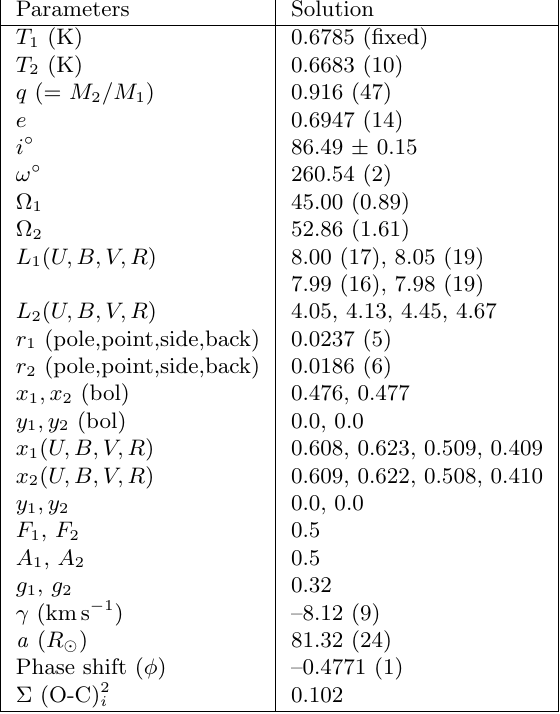
Table 2: Results of the light curve